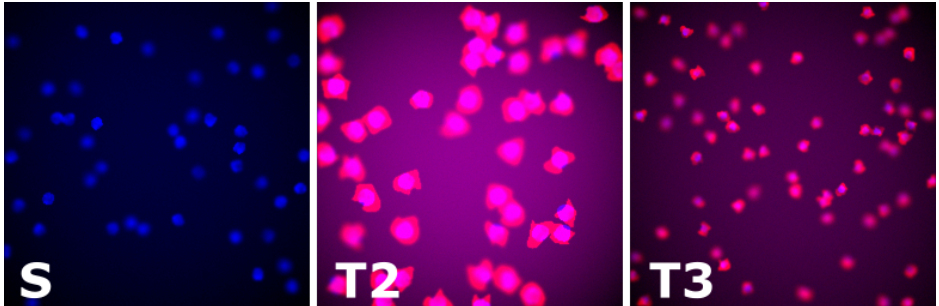
Figure 3. Samples of the cell datasets generated with [41]: S is the source dataset, and T2 and T3 are the target datasets. S and T 2 were designed to exhibit covariate shift only, whereas S and T 3 exhibit both covariate shift and label gap. (Best viewed in